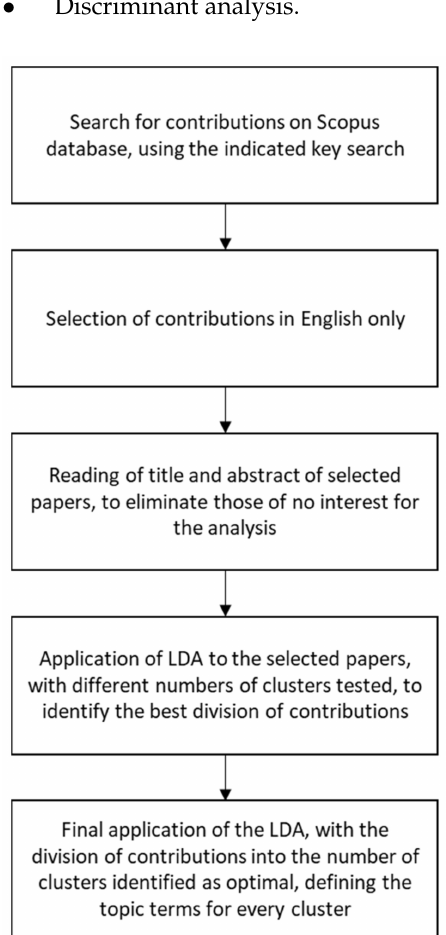
Figure 1. Literature research